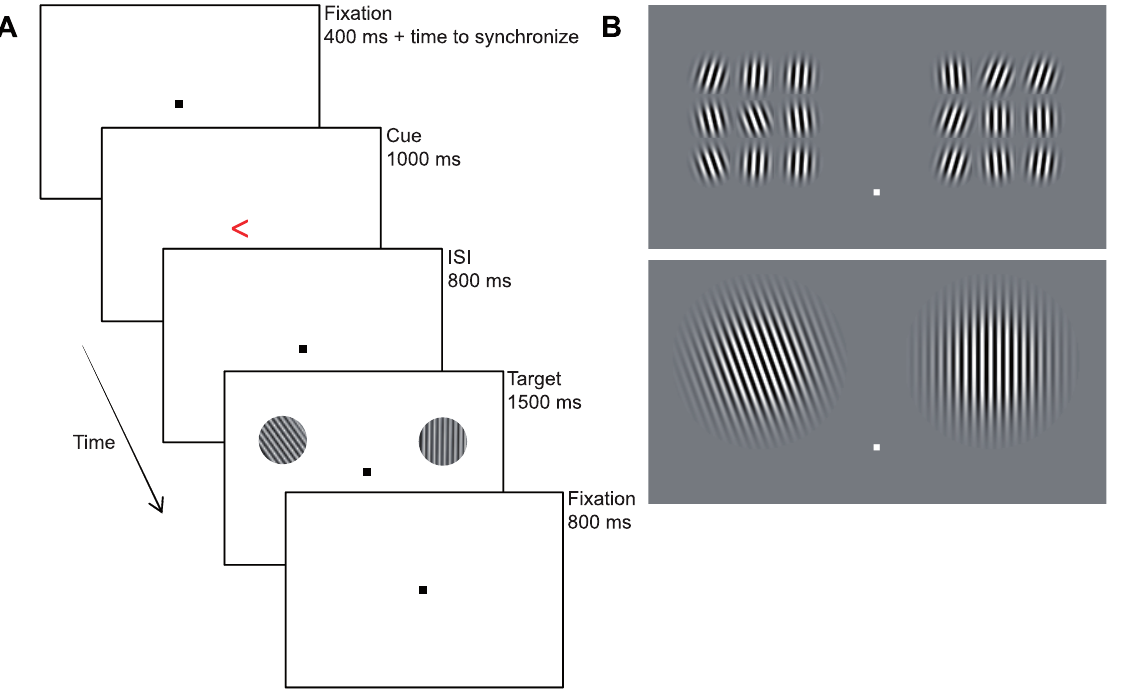
Figure 1. Time course and stimuli of a typical experimental trial. A) Participants focused on a central fixation point until a cue appeared. The cue indicated the visual hemifield in which the target would appear (arrow direction), as well as whether or not the target would be surrounded by distractors (arrow color). Participants responded to the orientation of the Gabor patch in the cued location only. B) Examples of actual target and distractor displays. The top-panel shows target and distractors, the target always being the middle patch on the cued side. The bottom panel shows the target display when no distractors were present.